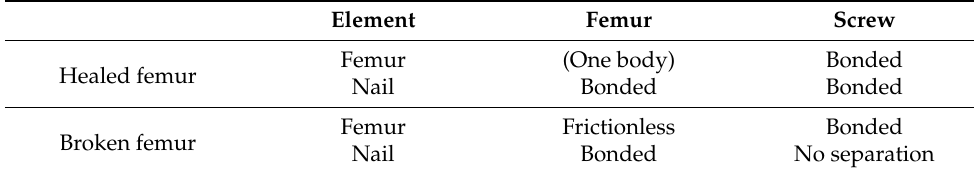
Table 3. Contacts (Ansys Workbench Mechanical software).